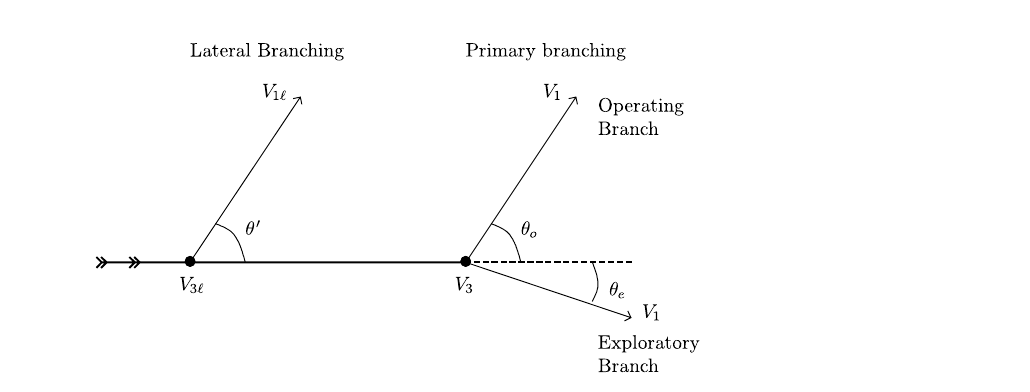
Figure 1. Thallus of P. anserina reconstructed from 8 × 14 tiles, extracted from experiment 12 15 h past the ascospore germination (see the text and Table 2 for more details).